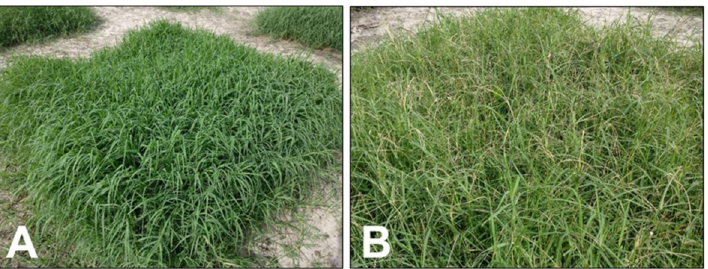
Figure 1. Contrasting bermudagrass response to natural infestations of bermudagrass stem maggot (BSM). The collection was visually rated for BSM tolerance using a 1 through 9 scale (1 = 10 percent or less damage, 9 = 90 percent or more damage). The PI 290664 showed a high tolerance level ( A ), and the cultivar Coastal was one of the most susceptible controls ( B